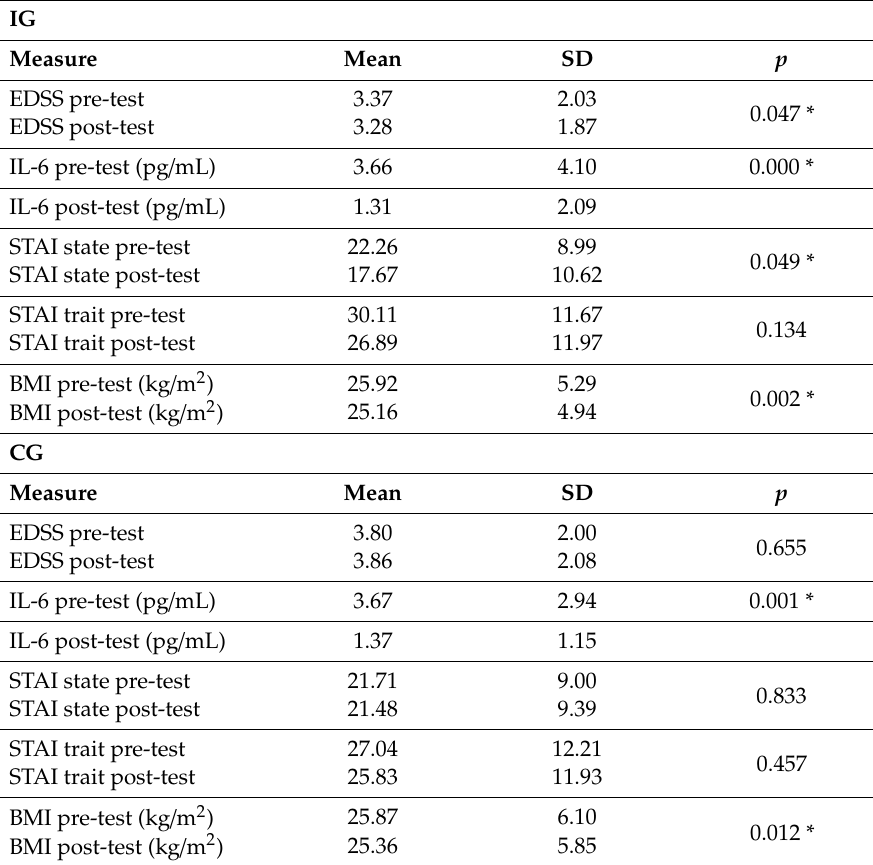
Table 2. Di ff erences between the study variables after